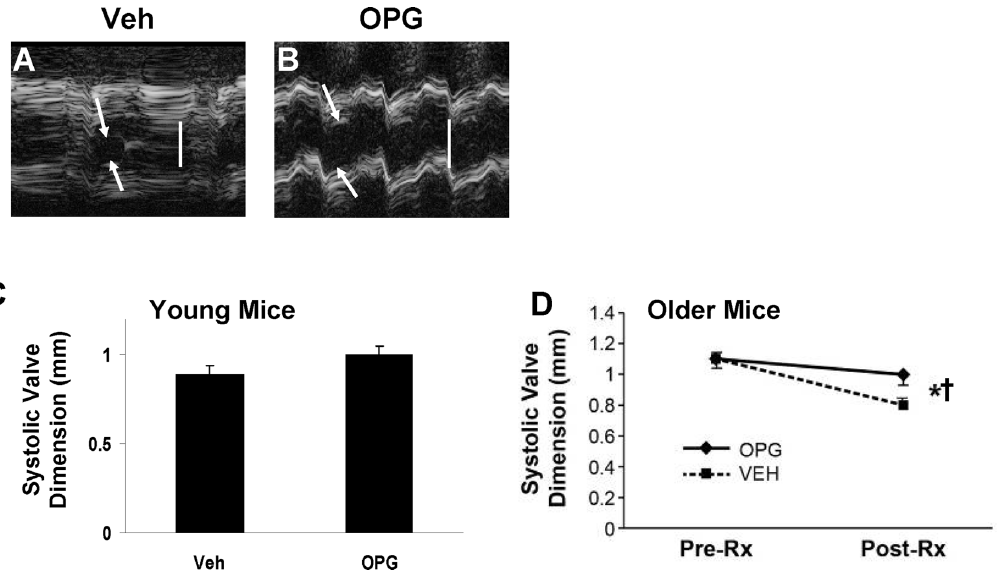
Figure 8. Aortic valve function. A,B : M-mode echocardiograms from Older mice depict aortic valve systolic dimension (arrows). Vertical white bar=1 mm. C : Aortic systolic valve dimension in Young Mice studied at age 8 mo. N=12, p=NS. D : Aortic valve systolic valve dimension in Older LA mice before (Pre-Rx, age 6 mo.) and after (Post-Rx, age 12 mo.) treatment with VEH or OPG, N=12. *p , 0.05 for VEH vs . OPG. { p , 0.05 for 12 mo. vs. 6 mo. for comparisons within each treatment